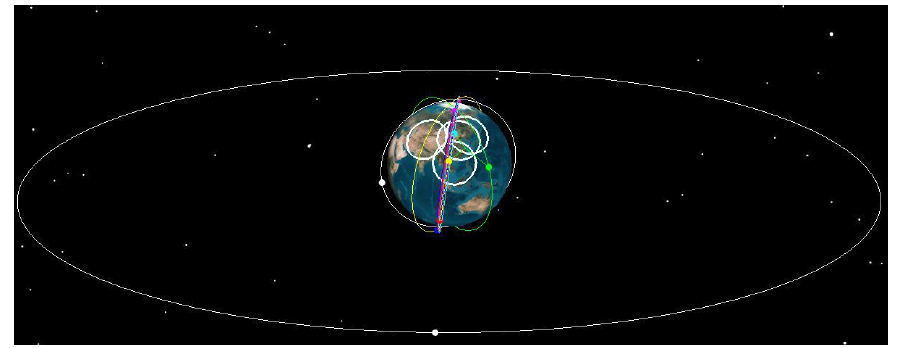
Figure 5. 3D diagram of the GF-resource satellite joint access to a moving target.